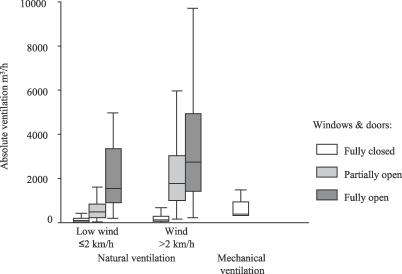
Effect of Window Opening and Wind Speed on Absolute VentilationThe effect of partial and complete window opening and wind speed on natural ventilation is shown, compared with mechanically ventilated negative-pressure respiratory isolation rooms. The triplet of bars on the left of the graph represents absolute ventilation measured in naturally ventilated clinical rooms on days when wind speed was within the lowest quartile (i.e., ≤2 km/h), with windows and doors closed (n = 102), partially open (n = 167), or fully open (n = 86). The triplet of bars in the centre of the graph represents absolute ventilation at wind speeds in the upper three quartiles combined (i.e., >2 km/h) with windows and doors closed (n = 266), partially open (n = 74) or fully open (n = 240). “Partially open” was defined as at least one window and/or door open, but not all. The single bar on the right of the graph represents absolute ventilation in mechanically ventilated negative-pressure respiratory isolation wards at 12 ACH. The corresponding median ACH for the seven bars from left to right are: 1.0; 7.6; 20; 1.8; 17; 34; and 12.